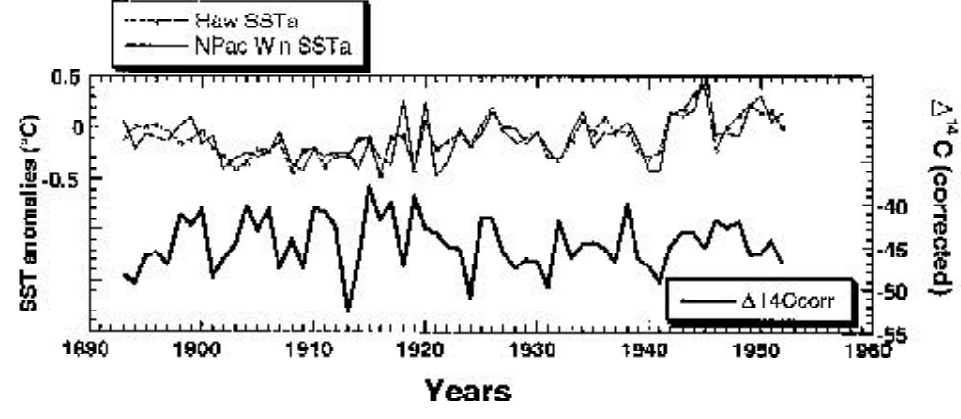
FIGURE 6. Winter sea-surface temperature anomalies in the North Pacific (30 to 50°N, 180–120°W), Hawaiian mean annual SST, and annual D 14 C record for corals from Hawaii, showing a positive correlation between SST and D 14 C (adapted from Druffel et